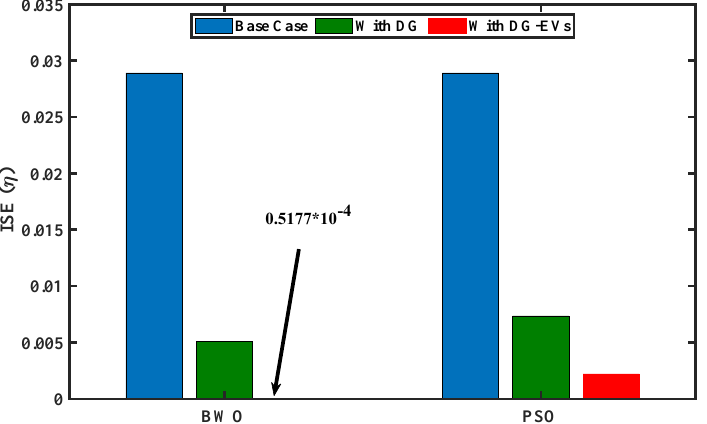
Figure 11. Integral square error using BWO and